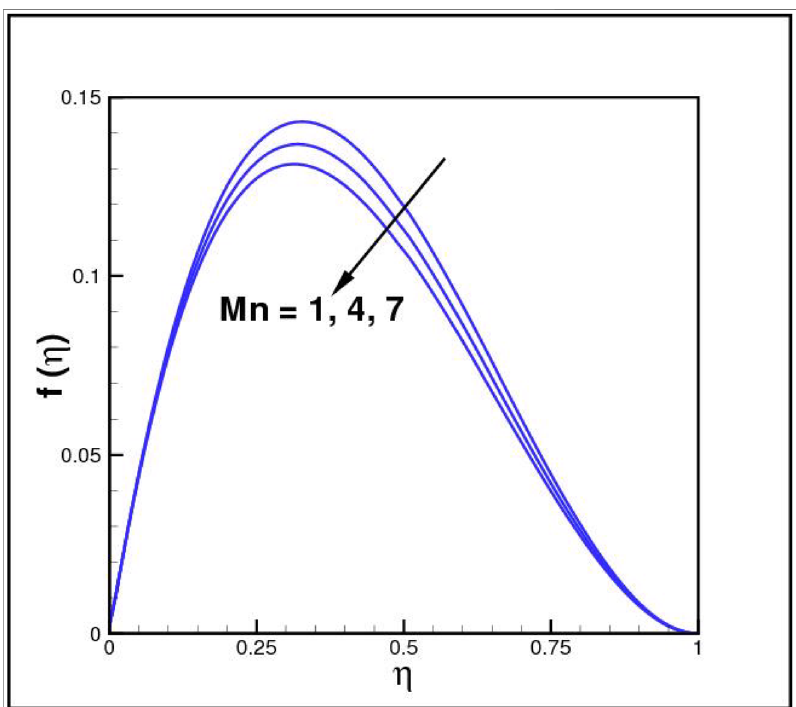
Figure 4. Impact of Mn on f ( η